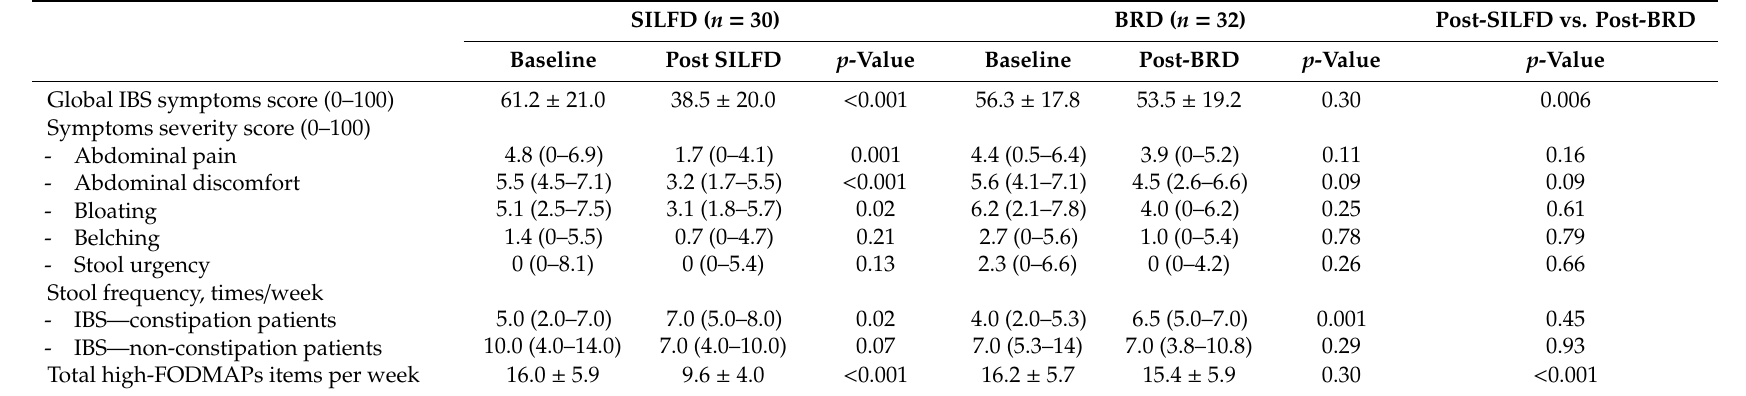
Table 2. Gastrointestinal symptoms compared between baseline and after structural individual low-FODMAPs diet advice (SILFD) and brief advice on a commonly recommended diet